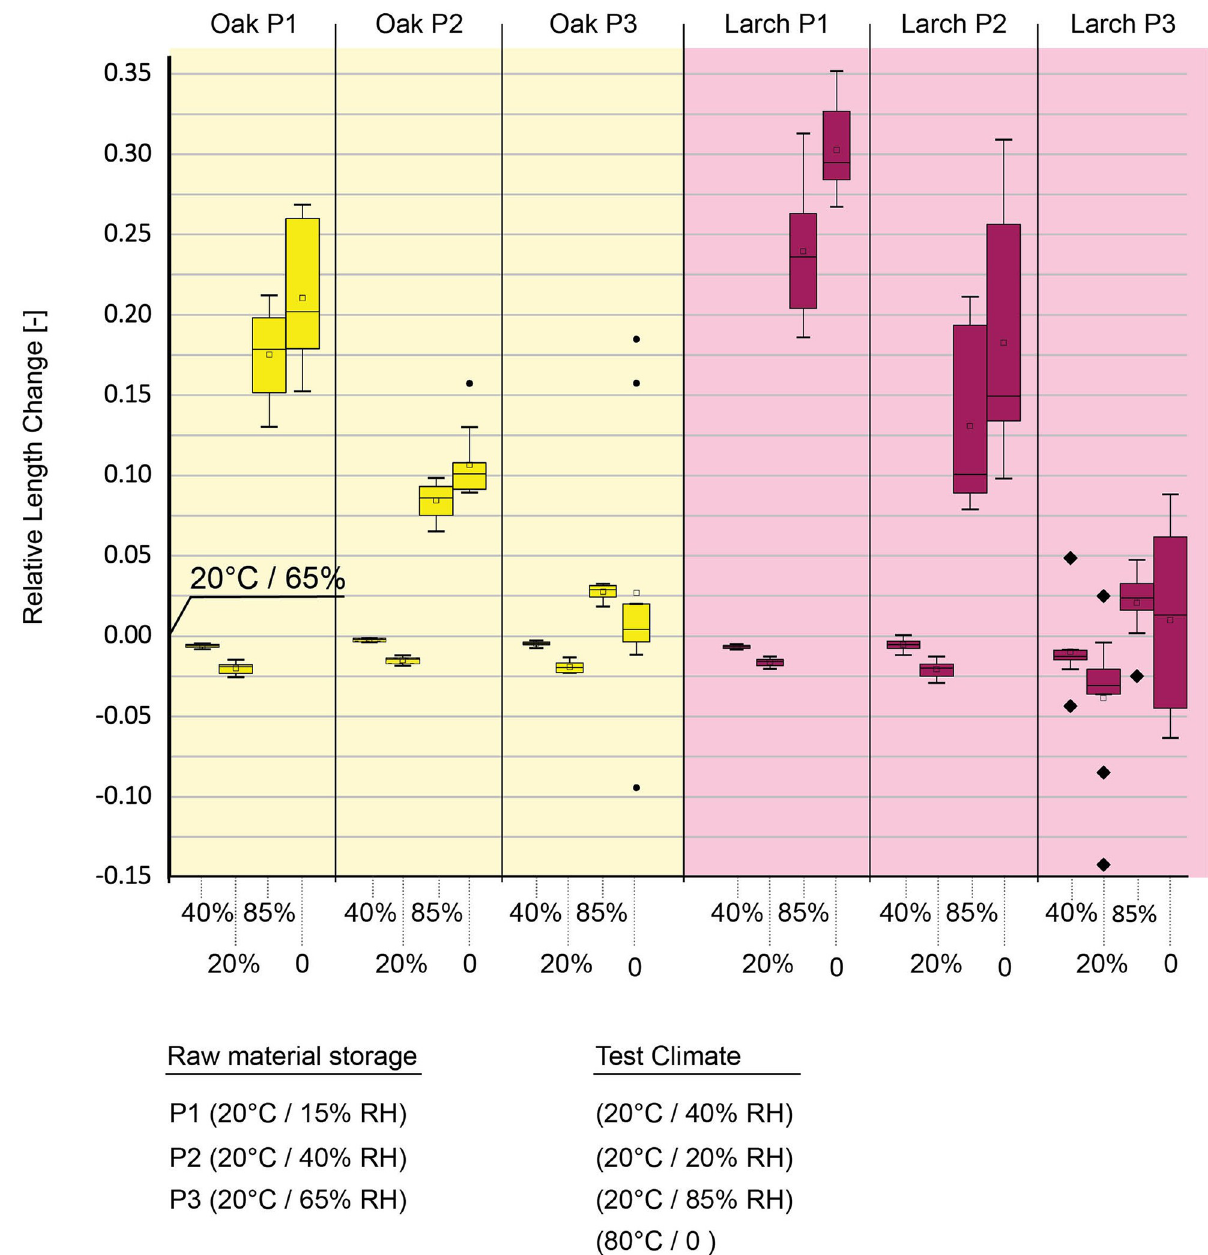
Fig 8. Swelling and shrinkage behavior of oak (yellow) and larch (pink) panels in the climate test.